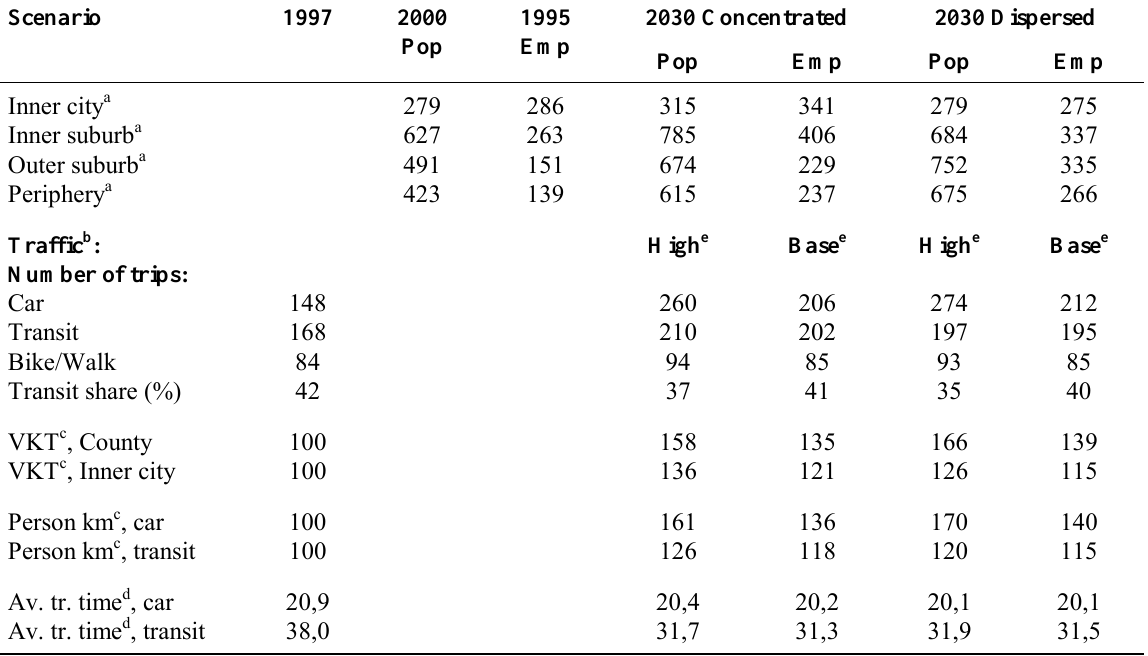
Table 4. Regional structures and transport patterns